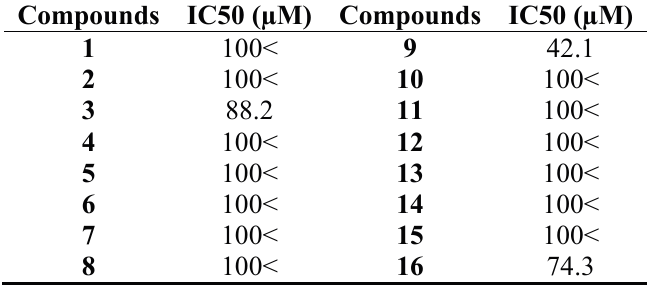
Table 1. Effects of isolates on production of nitric oxide (NO) in lipopolysaccharide (LPS)-induced RAW 264.7 cells. The cells (1 × 10 5 cells/mL) were pretreated with compounds 30 min prior to stimulation with LPS 24 hours after stimulation, the NO level of the supernatants was measured by Griess